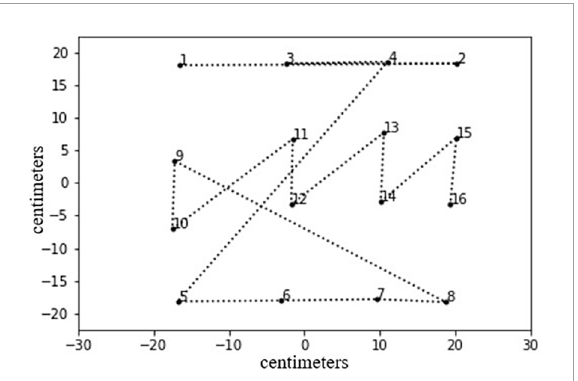
FIGURE2 An example of an E-BTT plot as used in the online survey. Black numbered dots represent each disk and the dashed line is the